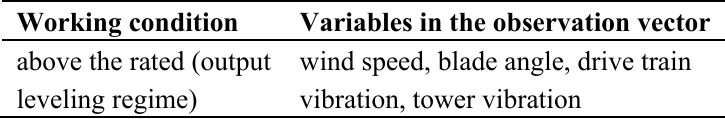
Table 3. Observation vector above rated wind